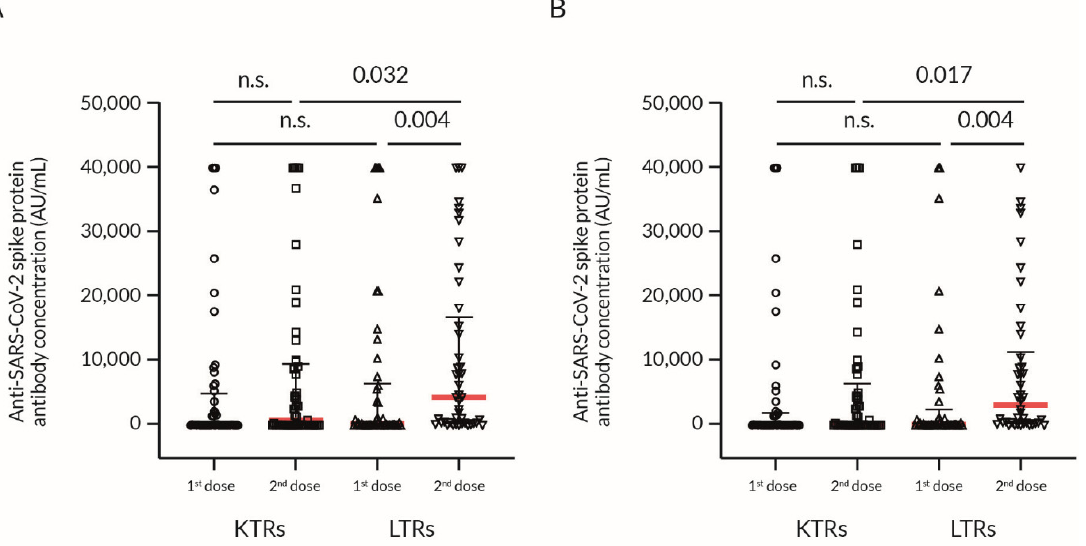
Figure 1. Enrollment flow chart and response to vaccination after the second dose of vaccine. * Other measurement units of anti-SARS-CoV-2 spike protein antibody titer than AU/mL. Anti-S1 Ab = anti-SARS-CoV-2 spike protein antibody; 1st dose = 4–6 weeks after the first dose of BNT162b2 vaccine; 2nd dose = 4–8 weeks after the first dose of BNT162b2 vaccine. LTRs produced a significantly higher anti-S1 Ab titer after the second dose of vaccine than KTRs (Figure 2A,B; Table 2); however, the difference between the Δ anti-S1 Ab in LTRs and KTRs was non-significant (Figure 3A,B).